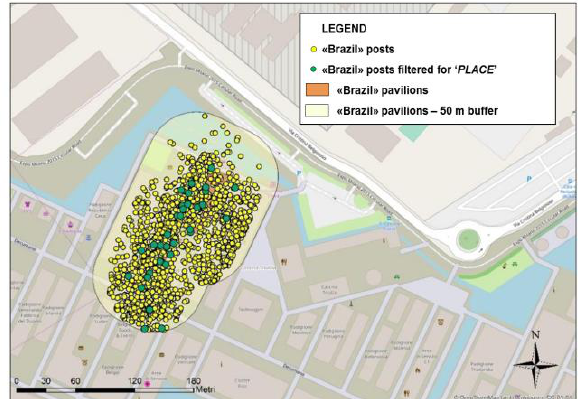
Figure 7. Example of results of the two-step Buffer-‘PLACE’ procedure for the semantic validation of the posts (case: Brazil pavilion); green dots represent the validated